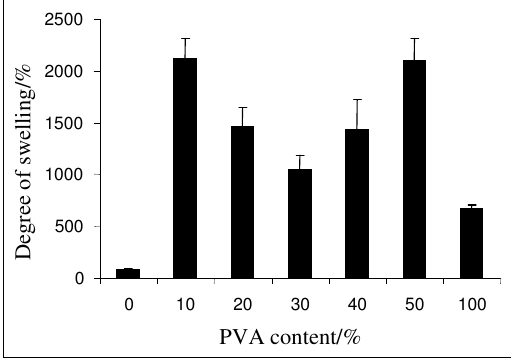
Figure 4. The swelling degree of chitosan, PVA and their blended films